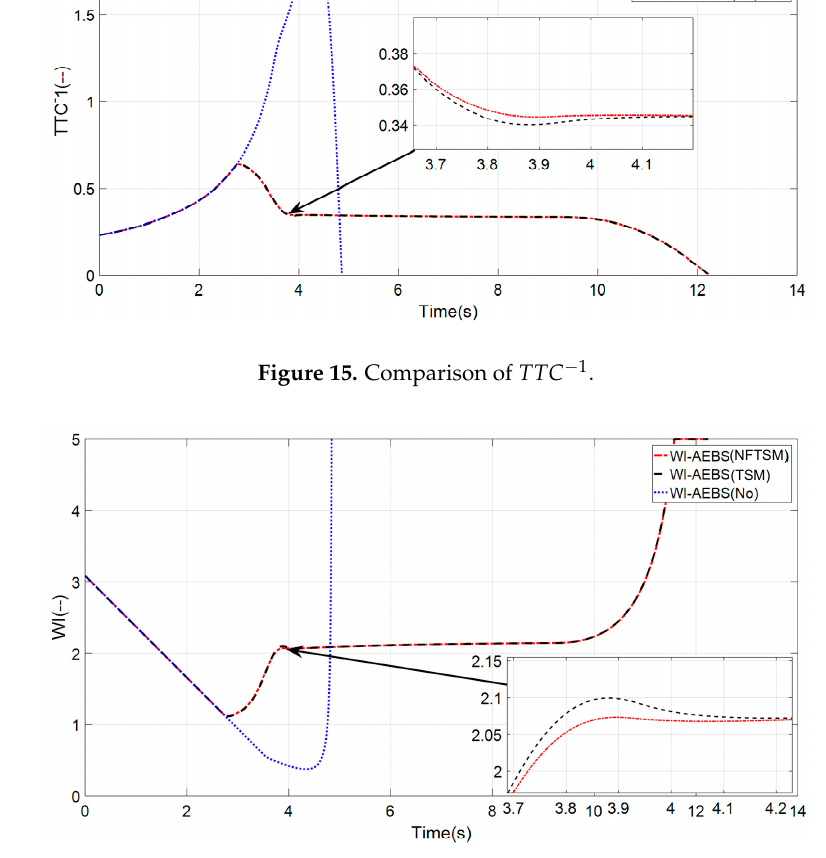
Figure 16. Comparison of WI .